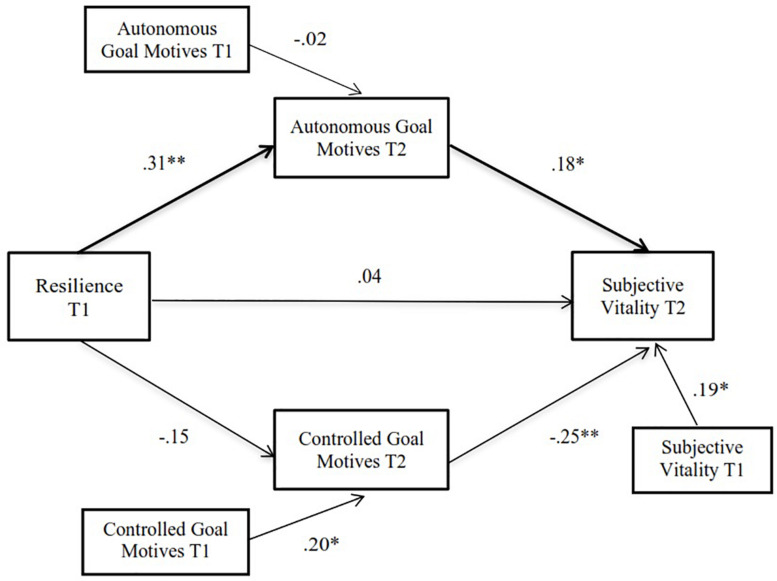
Path model of the associations between resilience, autonomous and controlled goal motives and subjective vitality over time. Statistics are standardized regression coefficients. Bold lines represent significant indirect paths. ∗p < 0.05; ∗∗p < 0.01.